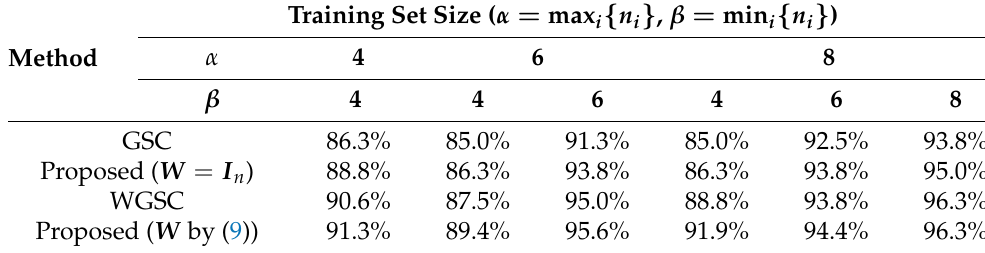
Table 2. Recognition results on the ORL